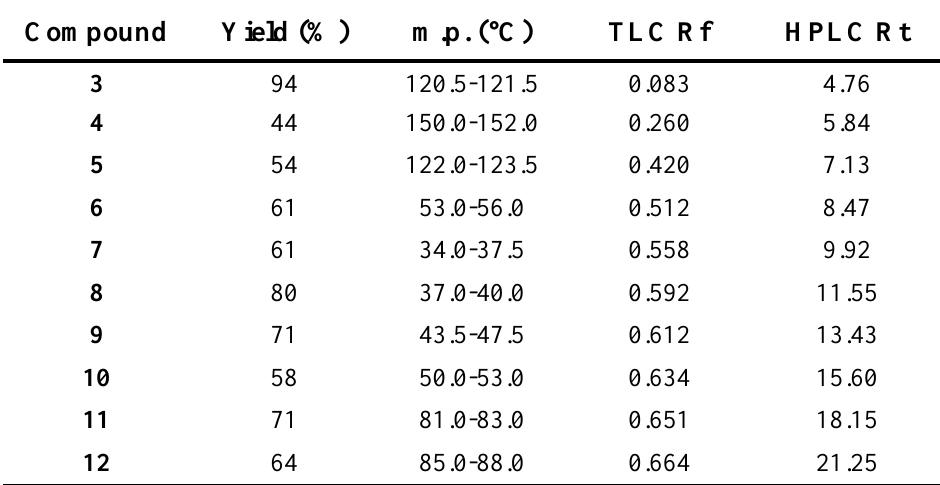
Table 1. Yields, melting points, retention factors and retention times of prepared bezalkonium